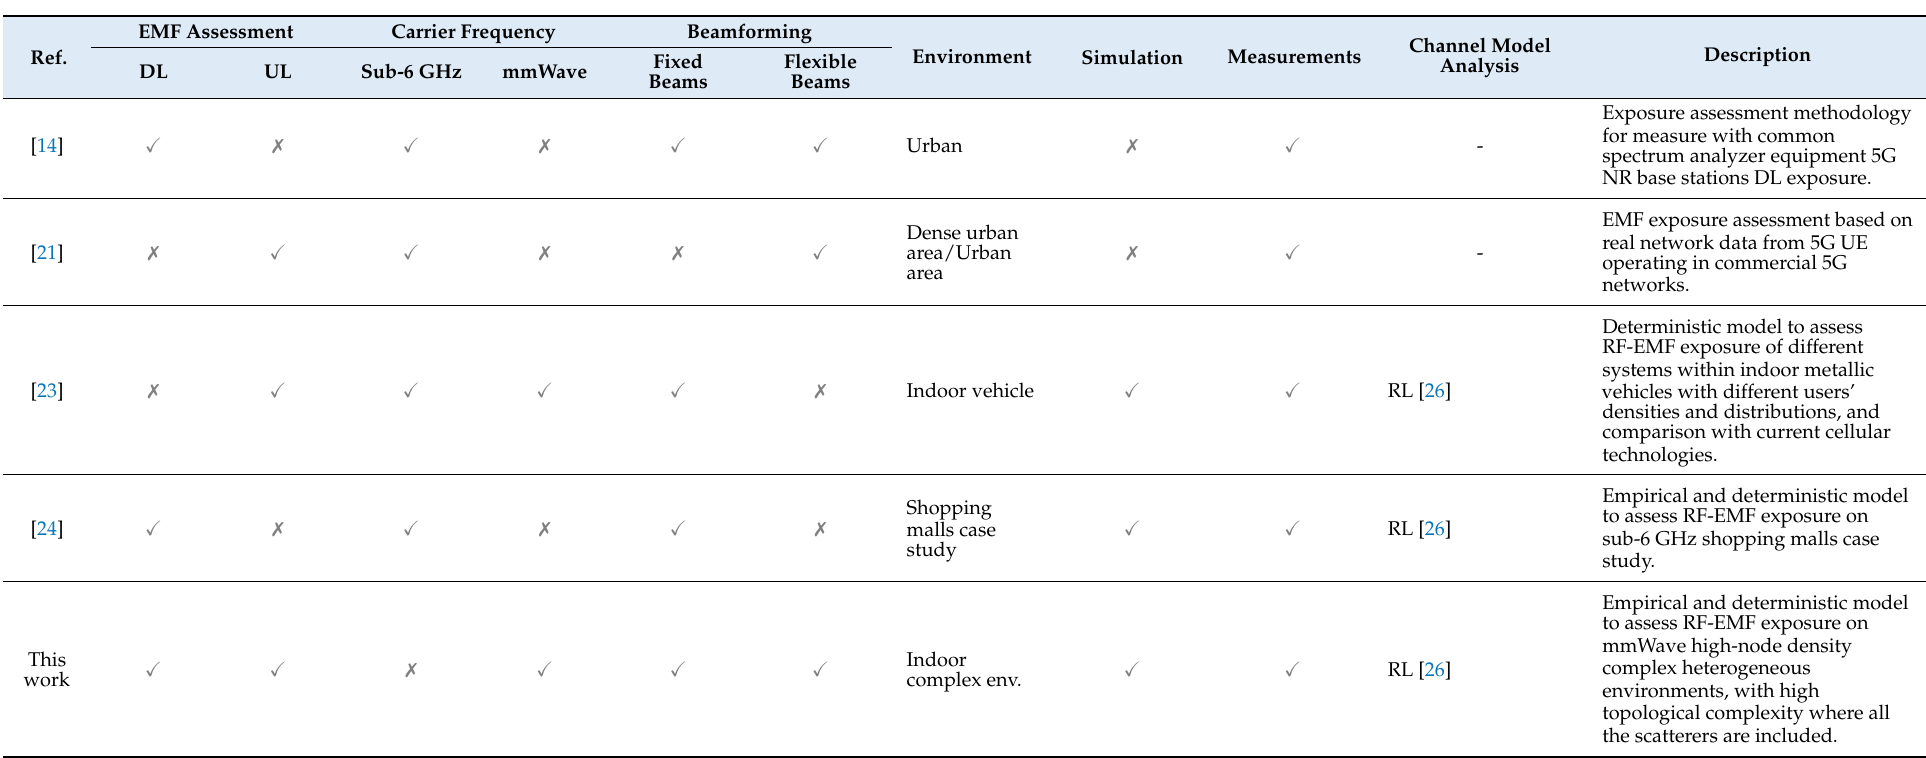
spectrum analyzer equipment 5G NR base stations DL exposure. EMF exposure assessment based on real network data from 5G UE operating in commercial 5G networks. Deterministic model to assess RF-EMF exposure of different systems within indoor metallic RL [26] vehicles with different users’ densities and distributions, and comparison with current cellular technologies. Empirical and deterministic model to assess RF-EMF exposure on RL [26] sub-6 GHz shopping malls case study. Empirical and deterministic model to assess RF-EMF exposure on mmWave high-node density complex heterogeneous RL [26] environments, with high topological complexity where all the scatterers are